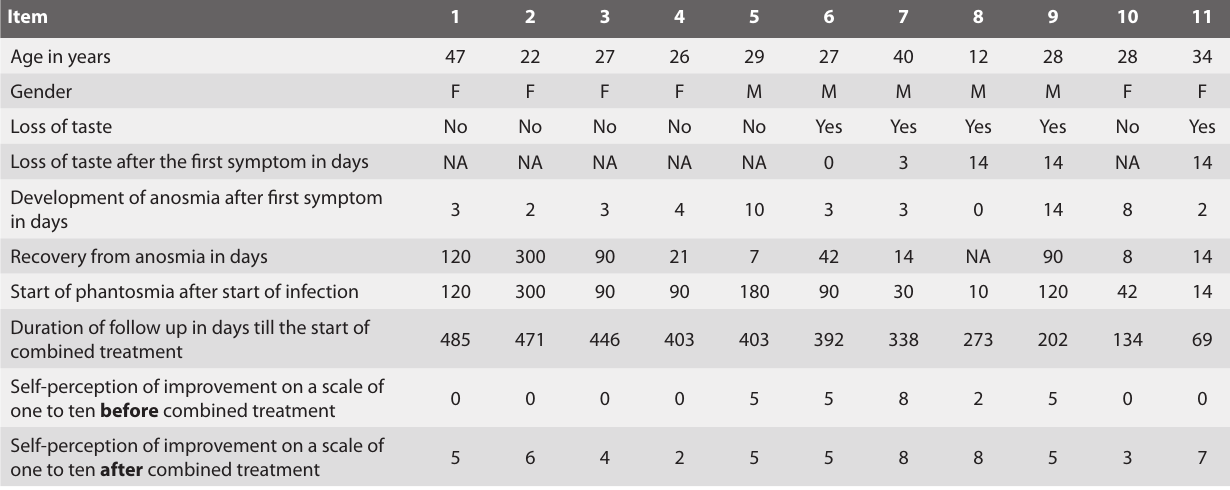
Table 2. Detailed characteristics of each patient (n =